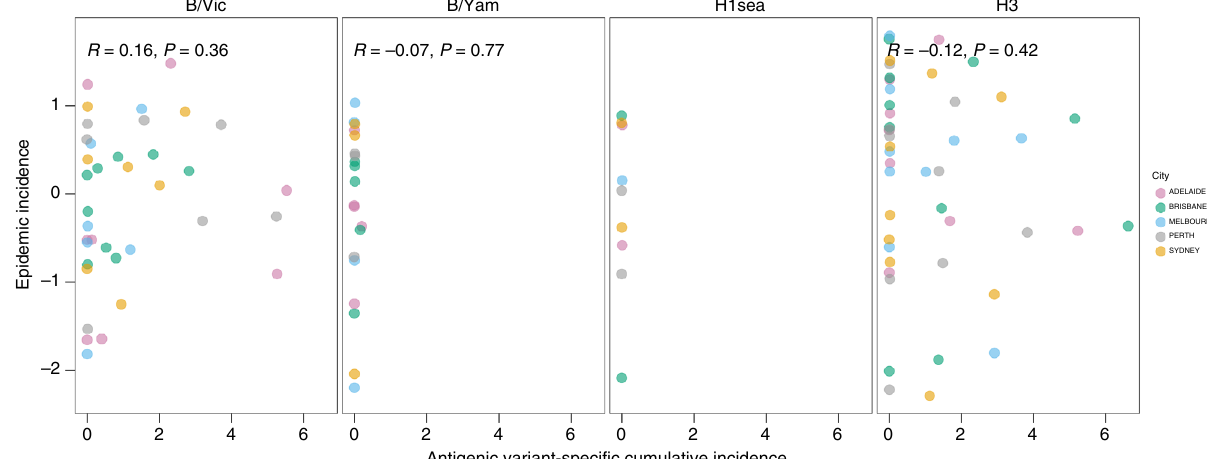
Fig. 4 Effect of prior immunity on epidemic incidence. Within each subtype, the incidence for individual epidemics was log-transformed and subtracted by the city-speci fi c mean of log incidence, to allow for comparison between cities. Antigenic variant-speci fi c cumulative incidence was measured relative to the city-speci fi c mean epidemic size, where 1 is equivalent to the mean epidemic incidence. r - and P values are from Pearson ’ s correlation tests ( n = 37, 20, 9 and 45 for B/Vic, B/Yam, A/H1sea and A/H3, respectively). Antigenic variants of B/Yam rarely initiated multiple epidemics during the study period, and it was not possible to calculate a correlation coef fi cient for A/H1sea because the one new antigenic variant to emerge during the study period caused only a single epidemic per